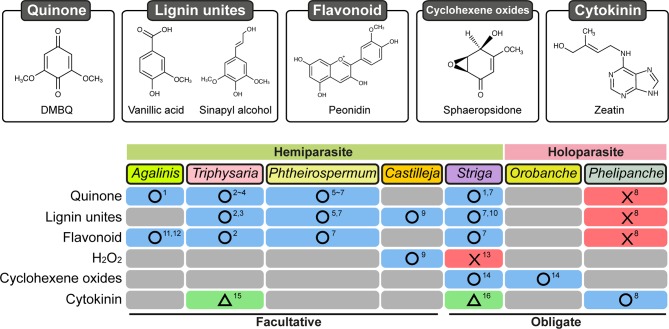
Response of Orobanchaceae parasitic plants treated with various chemicals for haustorium induction. Chemical categories previously reported as HIFs are shown on the left. Blue boxes with circles: at least one chemical was reported in the corresponding species. Red boxes with crosses: tested chemical(s) did not induce haustoria. Green boxes with triangles: haustoria-like structures were reported. Gray boxes: not reported. Numbers indicate references: 1, Chang and Lynn (1986); 2, Albrecht et al. (1999); 3, Bandaranayake et al. (2010); 4, Bandaranayake et al. (2012); 5, Cui et al. (2016); 6, Ishida et al. (2016); 7, Cui et al. (2018); 8, Goyet et al. (2017); 9, Salcedo-Morales et al. (2013); 10, Lynn and Chang (1990); 11, Lynn et al. (1981); 12, Steffens et al. (1982); 13, Wada et al. (2019); 14, Fernández-Aparicio et al. (2016b); 15, Wrobel and Yoder (2001); 16, Keyes et al. (2000).